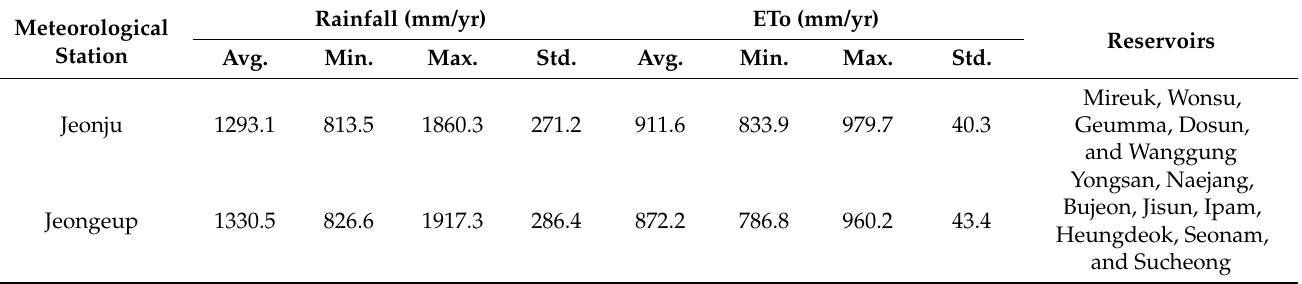
Table 2. Statistics of rainfall and reference evapotranspiration in the studied agricultural reservoirs